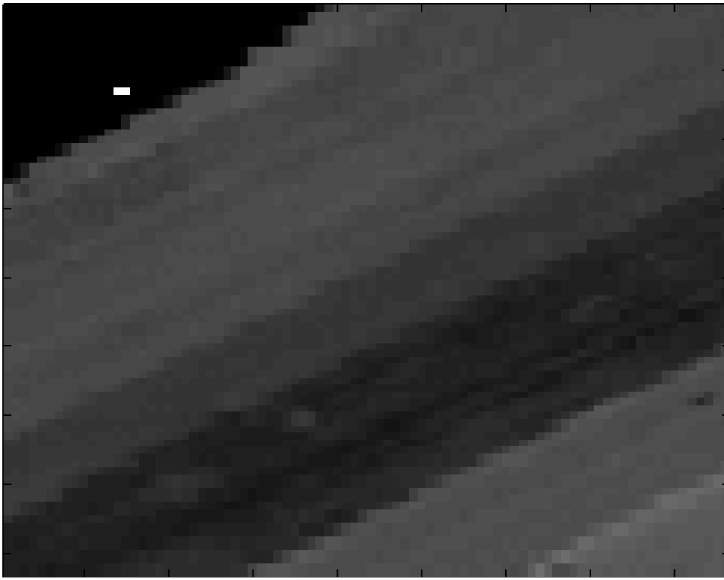
Figure 1. Sample band of Salinas-A dataset.